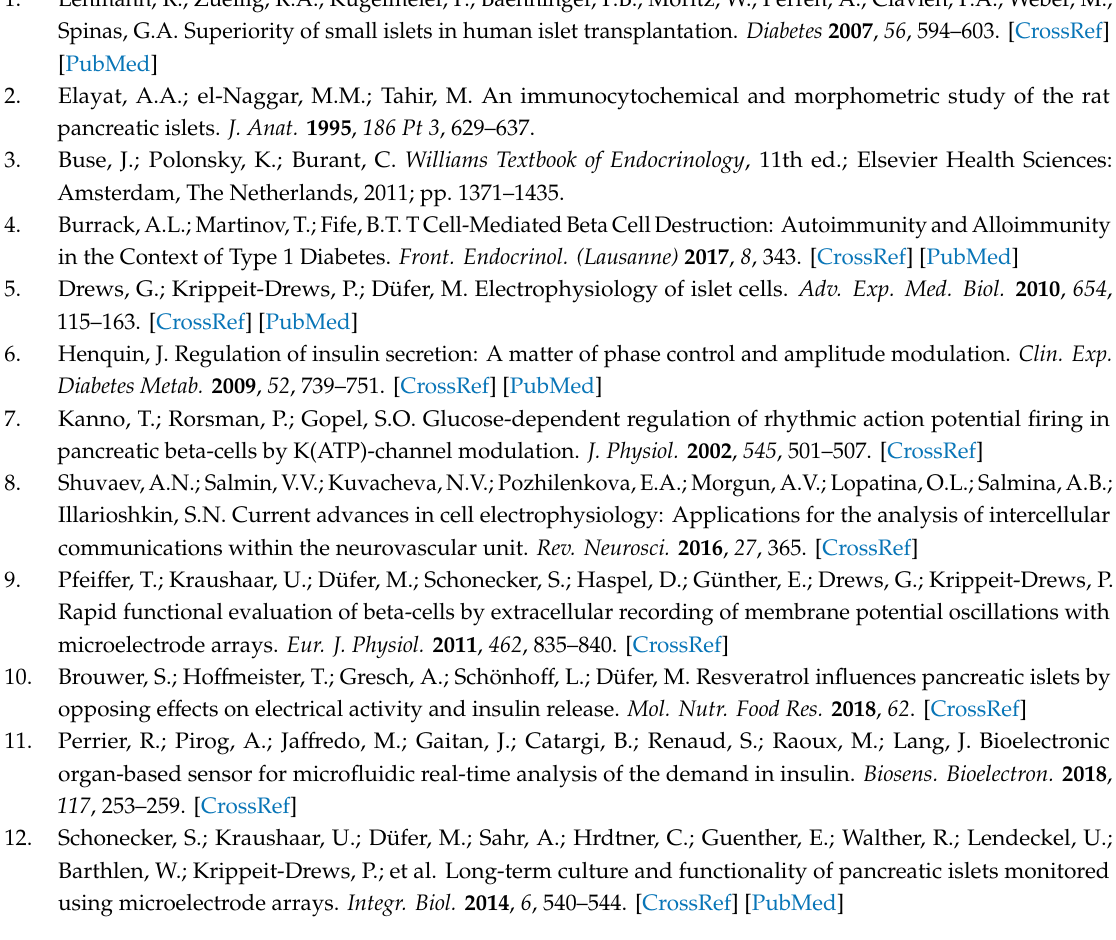
Figure S1: Glucose stimulated insulin secretion for functional assessments. Insulin concentration by dissociated islets on each MEA under low (1.1 mM) and high (16.7 mM) glucose media for the di ff erent culture days, Figure S2: Assessment of FOPP. Quantification of FOPP of each MEA for low (1.1 mM) and high (16.7 mM) glucose media for the di ff erent culture